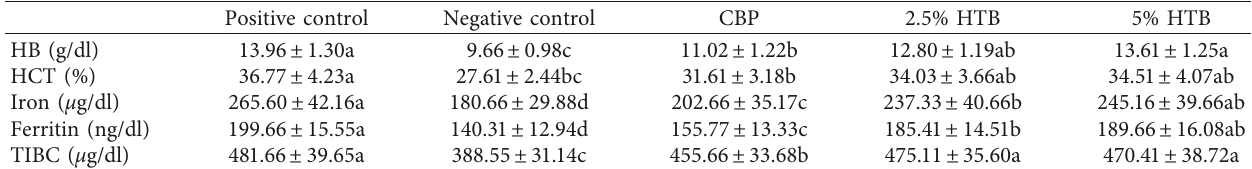
Table 7: Effect of the beef burger fortified with different ratios of husk tomato powder on blood HB, HCT, iron, ferritin, and TIBC of anaemic rats (mean values ± SD).